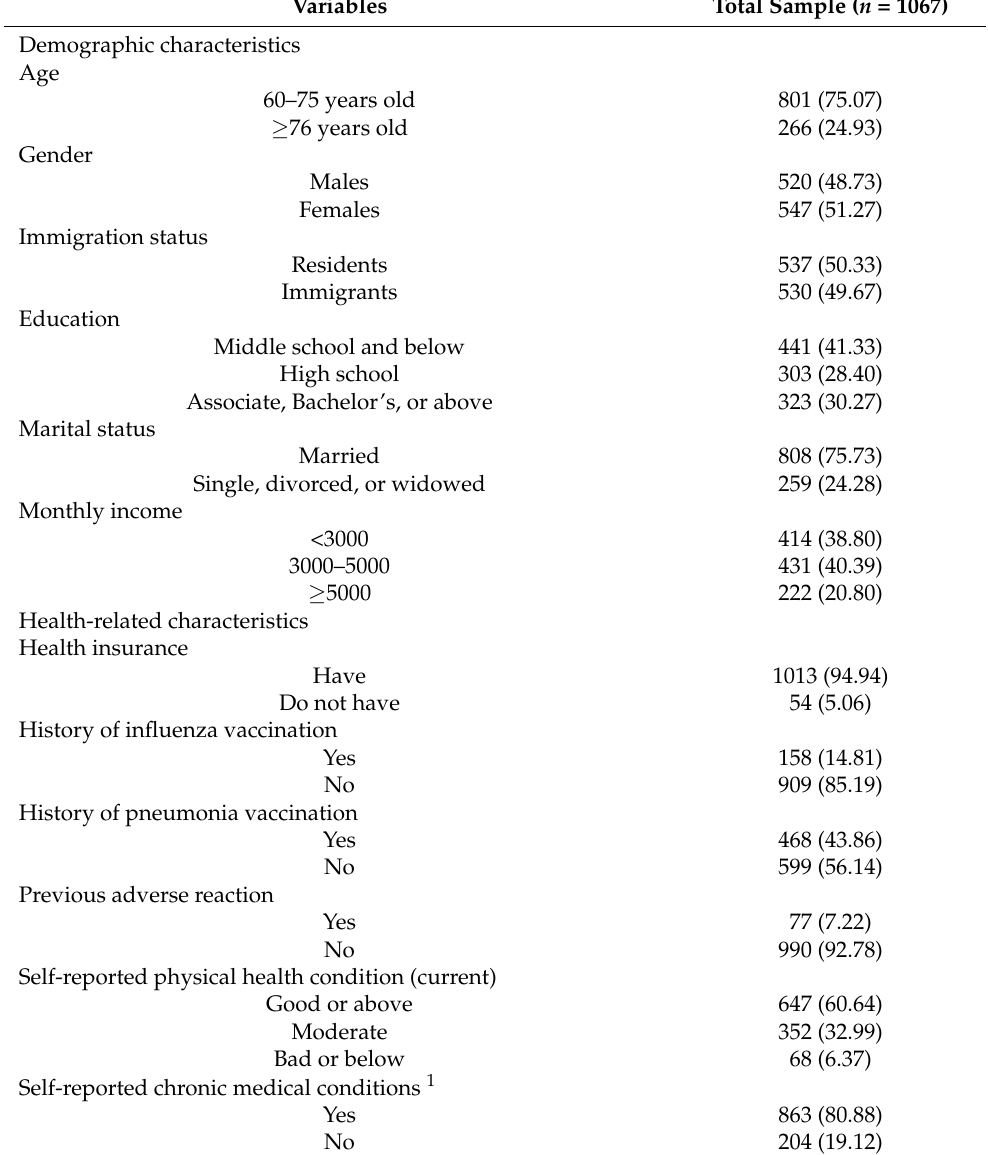
Table 1. Demographic and health-related characteristics of